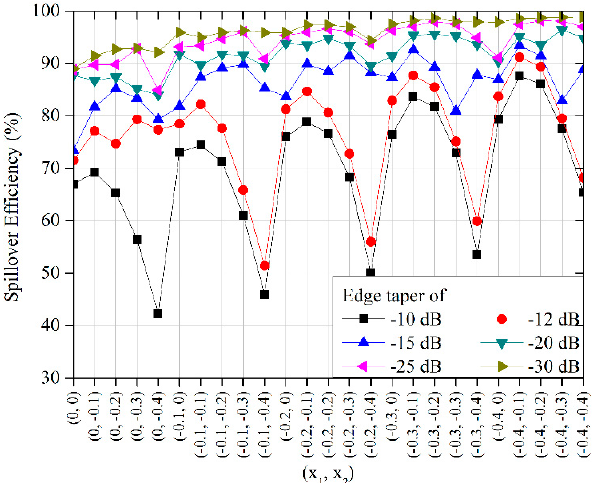
Figure 8. Comparison of spillover efficiency for several edge tapers (at 140 GHz) for horn antennas with 3 node points.